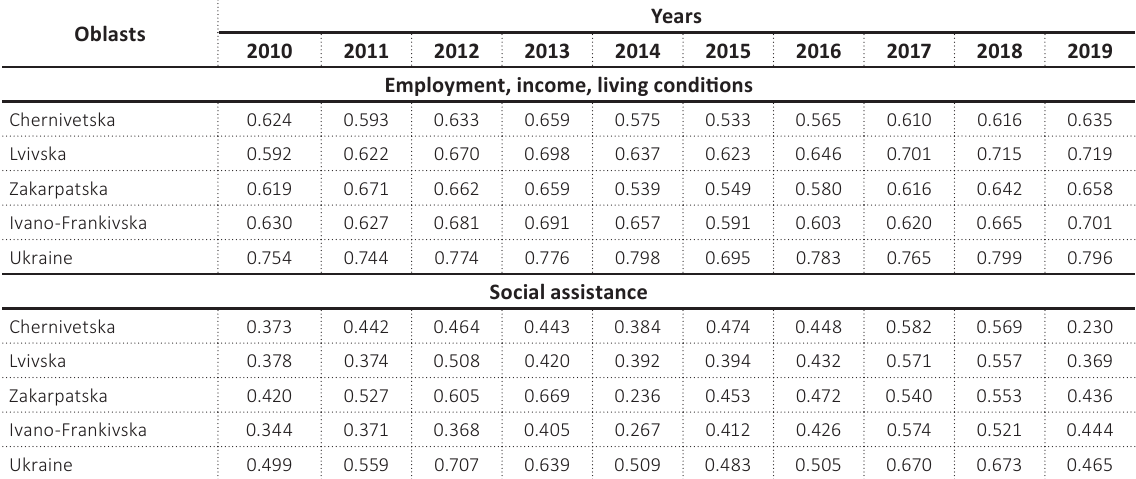
Table 1. The population’s social resilience environment of Ukraine and the Carpathian region: by employment, income, and living conditions and social assistance groups, 2010–2019 Source: Developed based on the authors’ calculations.